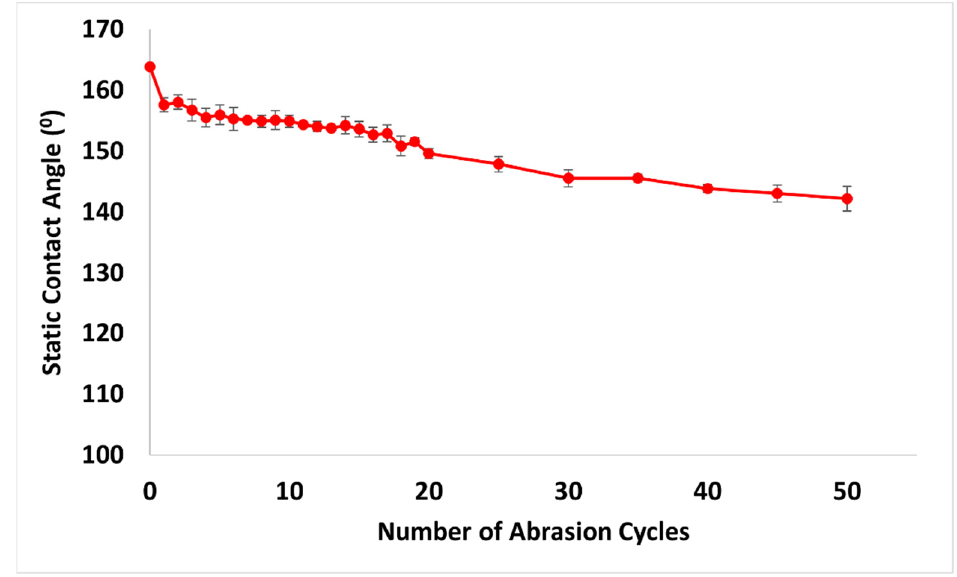
Figure 4. Static contact angles after abrasion against a 240-grit sandpaper with 7.75 kPa normal load .